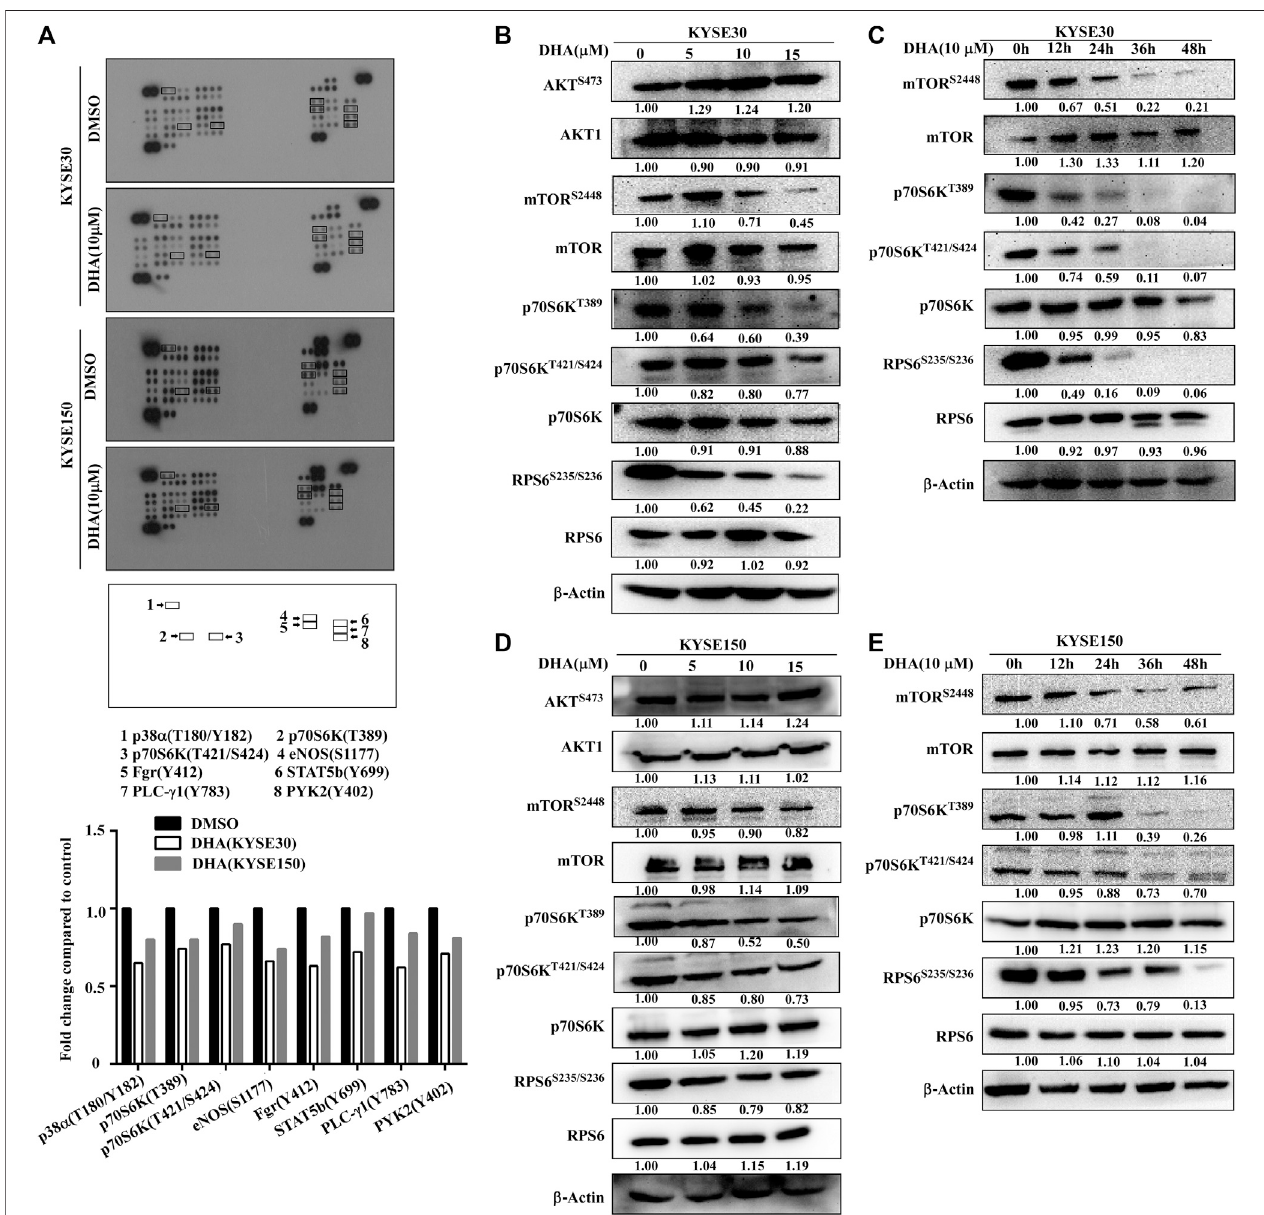
FIGURE 3 | DHA attenuats phosphorylation levels of mTOR-p70S6K-RPS6. (A) Phospho-protein array analysis. Array spots were visualized using an ECL kit (above).Thegraphshowsthefoldchange.Dataareshownasanaverageofduplicatesamples(below). (B) WiththeincreasingconcentrationofDHAinKYSE30cells(0, 5,10,or15 μ M),thelevelsofp-mTOR S2448 ,p-p70S6K T389 ,p-p70S6K T421/S424 andp-RPS6 S235/S236 weredecreased,con fi rmedusingwesternblotanalysis. (C) Asthe timeofDHAtreatmentinKYSE30cells(0,12,24,36,or48 h)increased,thelevelsofp-mTOR S2448 ,p-p70S6K T389 ,p-p70S6K T421/S424 ,andp-RPS6 S235/S236 also decreased, con fi rmed using western blot analysis. (D) With the increasing concentration of DHA in KYSE150 cells (0, 5, 10, or 15 μ M), the levels of p-mTOR S2448 , p-p70S6K T389 , p-p70S6K T421/S424 , and p- RPS6 S235/S236 decreased, con fi rmed using western blot analysis. (E) As the time of DHA treatment in KYSE150 cells (0, 12, 24, 36, or 48 h) increased, the levels of p-mTOR S2448 , p-p70S6K T389 , p-p70S6K T421/S424 and p- RPS6 S235/S236 decreased, con fi rmed using western blot analysis. Densitometry analyses were performed for all the western blot analyses using by ImageJ.